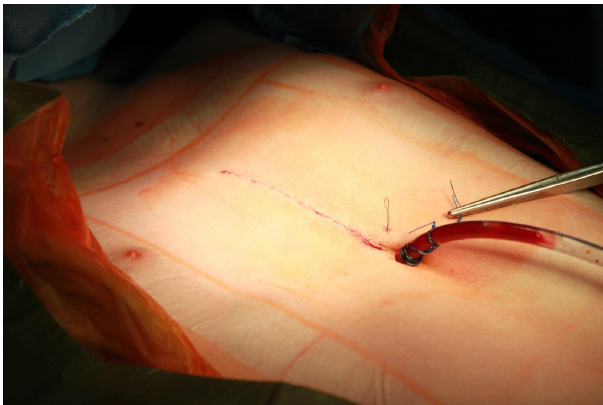
Image 6. Suture fixation of the costal cartilages to the sternum and the xiphoid process to the body of the sternum (the main highlights of the modified Ravitch procedure).